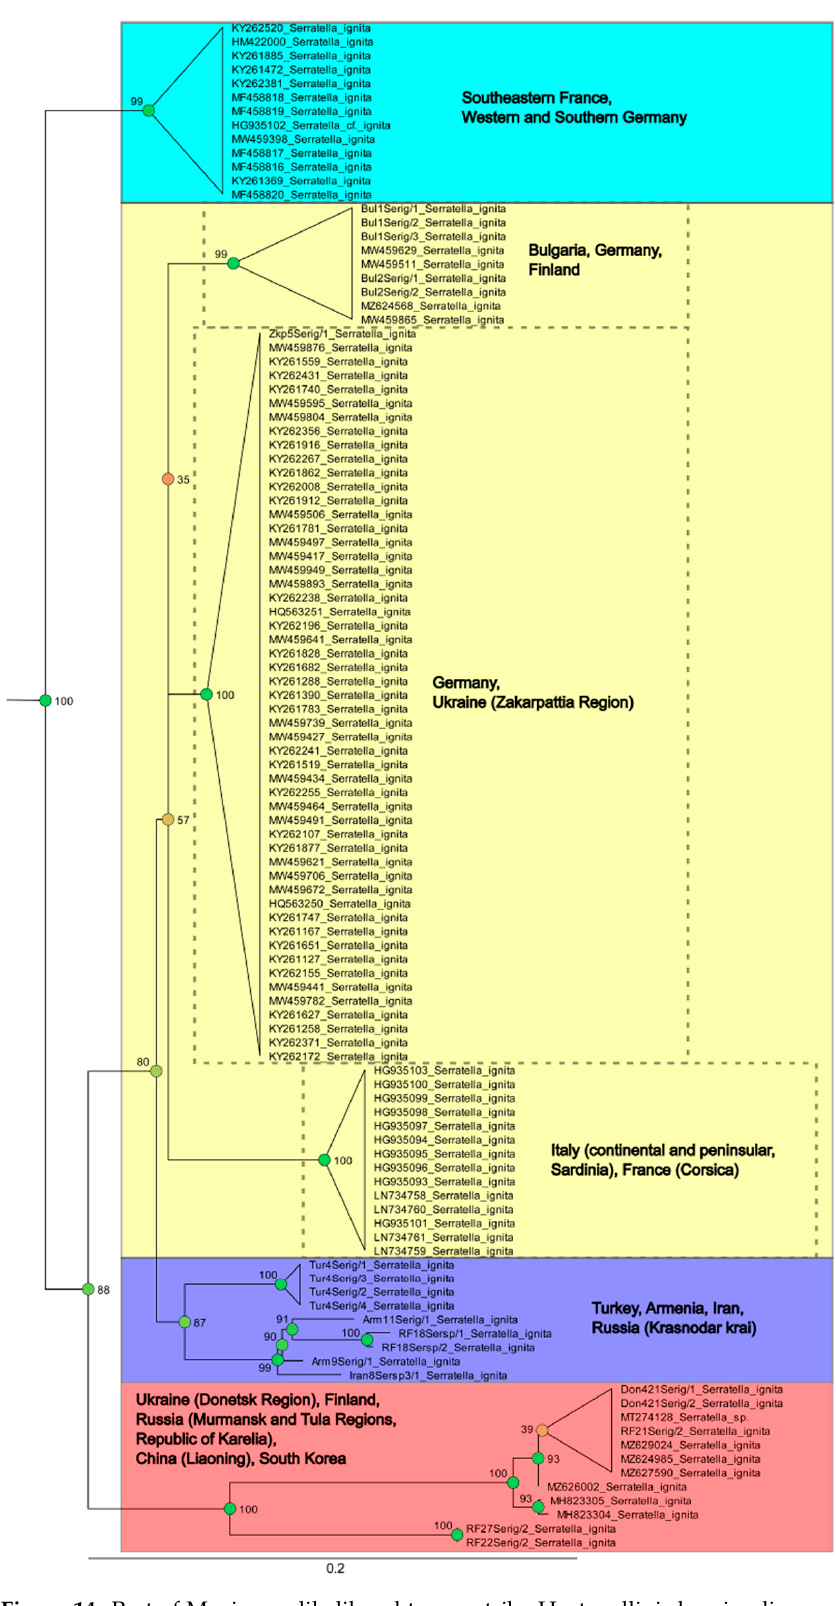
Figure 14. Part of Maximum likelihood tree on tribe Hyrtanellini showing lineage with Serratella ignita (Poda, 1761). Branches provided with Bootstrap supports (BS). Support values are colored based on confidence at internal nodes; from yellow (low) to green (high). Blue, yellow, purple and coral backgrounds mark the most distinct clades within lineage with S. ignita .